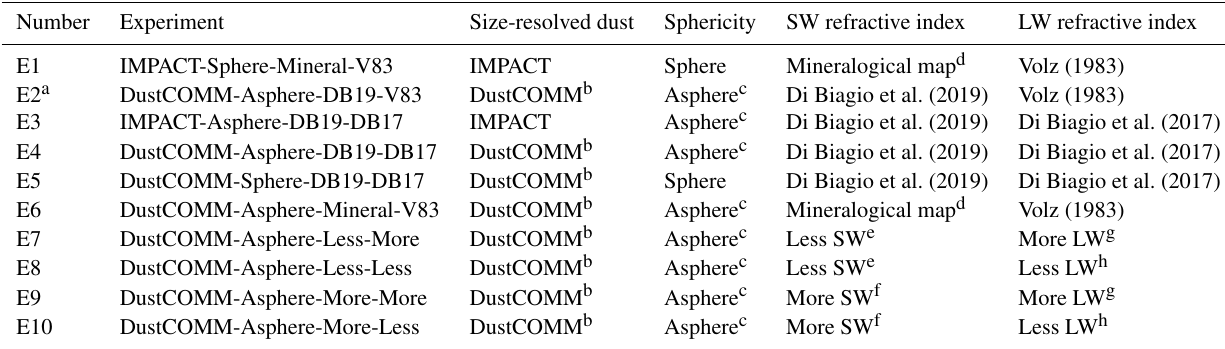
Table 1. Summary of 10 combinations of different numerical experiments compared in this study.